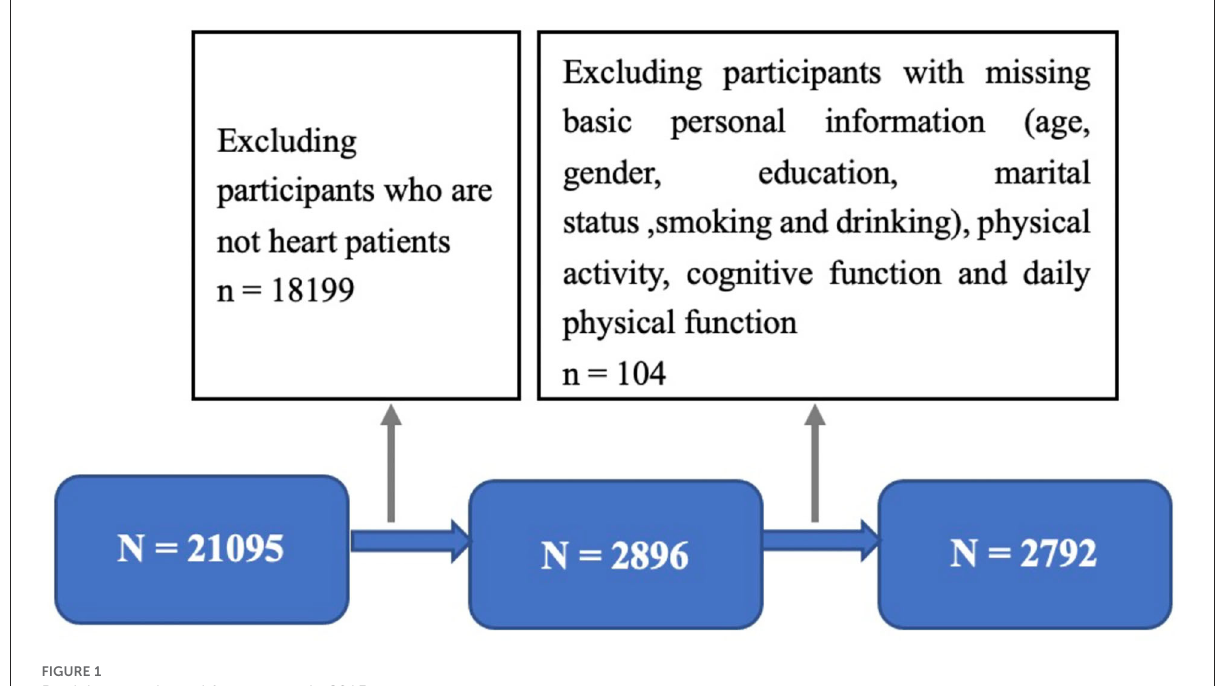
FIGURE1 Participants selected from survey in